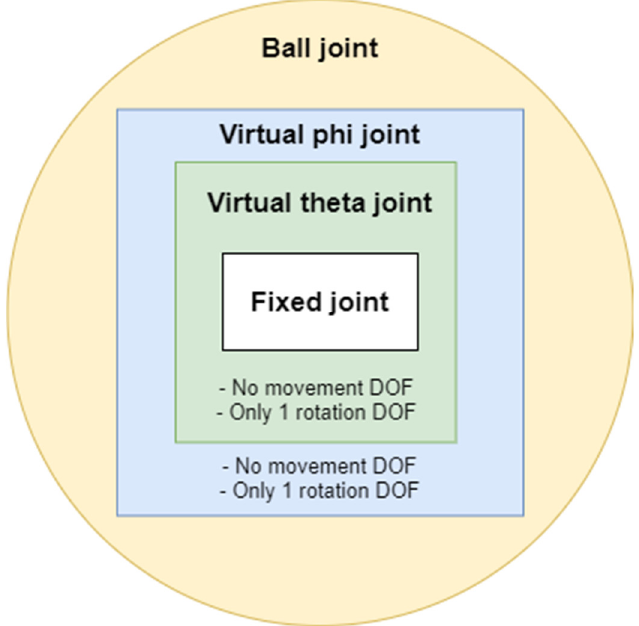
Figure 6 . Ball joint structure in Gazebo . Figure 6. Ball joint structure in